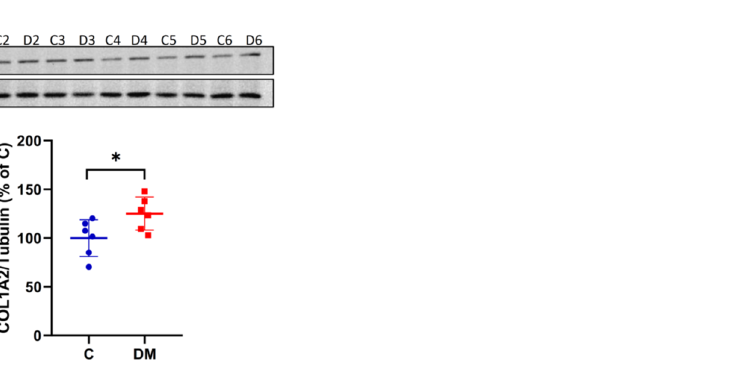
Figure 2. STZ-induced diabetic cardiomyopathy and cardiac fibrosis. ( A ) Heart rate—HR, n = 20. ( B ) Mean blood pressure—MBP, n = 20. ( C ) Heart weight—HW, n = 10. ( D ) Ratio of heart weight/tibial length—HW/TL, n = 10. Data are expressed as mean ± SEM. p -values were determined by Student‘s t -test. ( E ) Images of individual cardiomyocytes (scale bar = 20 µ m). ( F ) Masson trichrome staining to detect fibrosis in interstitial (top) and perivascular (bottom) tissue (scale bars = 100 µ m). ( G ) Cardiac COL1A2 protein levels and their quantitative results, n = 6. Data are expressed as mean ± SEM. p -values were determined by Student’s t -test. * p < 0.05 DM vs. C.